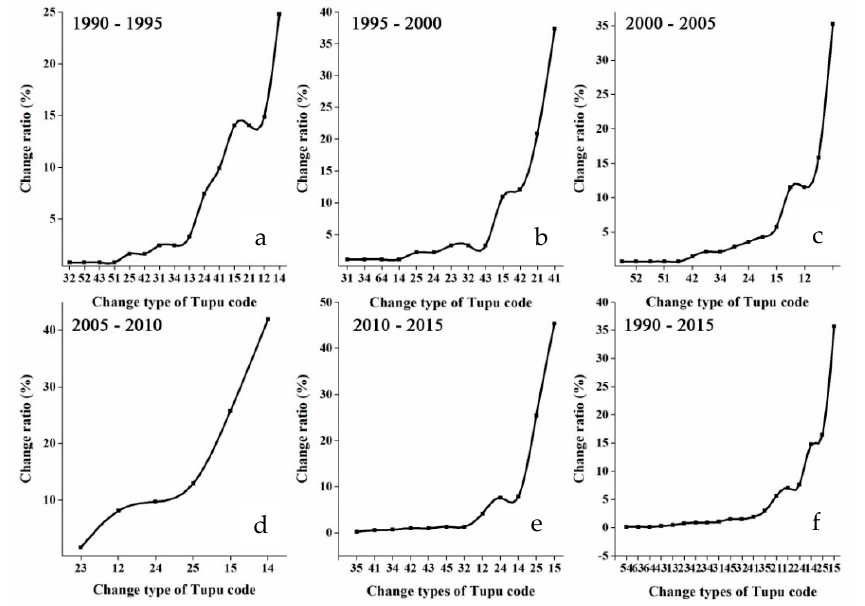
Figure 3. Change ratio of Tupu units of land use change during 1990–2015 in the Exibei region. ( a ): farmland; ( b ): forestland; ( c ): grassland; ( d ): water land; ( e ): construction land; ( f ): unused land. Tupu code was the transition type of land use changes, e.g., Tupu code AB , which meant that the land use type from type A at the former period to type B at the latter period.